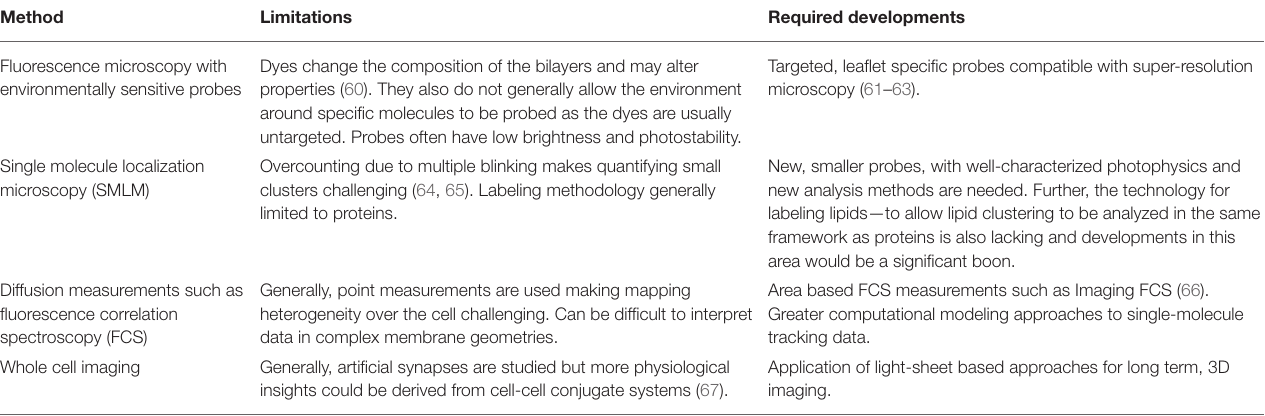
TABLE 1 | Fluorescence methods applied to study membrane protein and lipid clustering, their limitations and suggestions for future development.